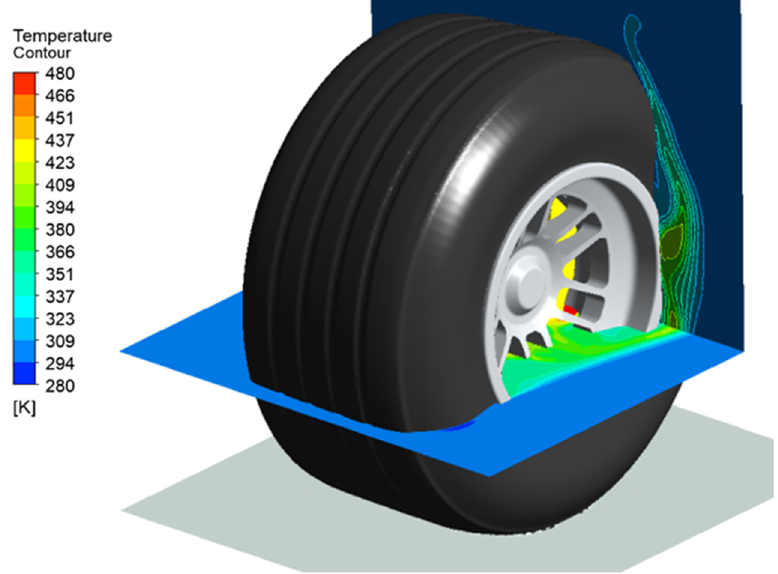
Figure 13. Temperature contours on the planes X2-Z1.